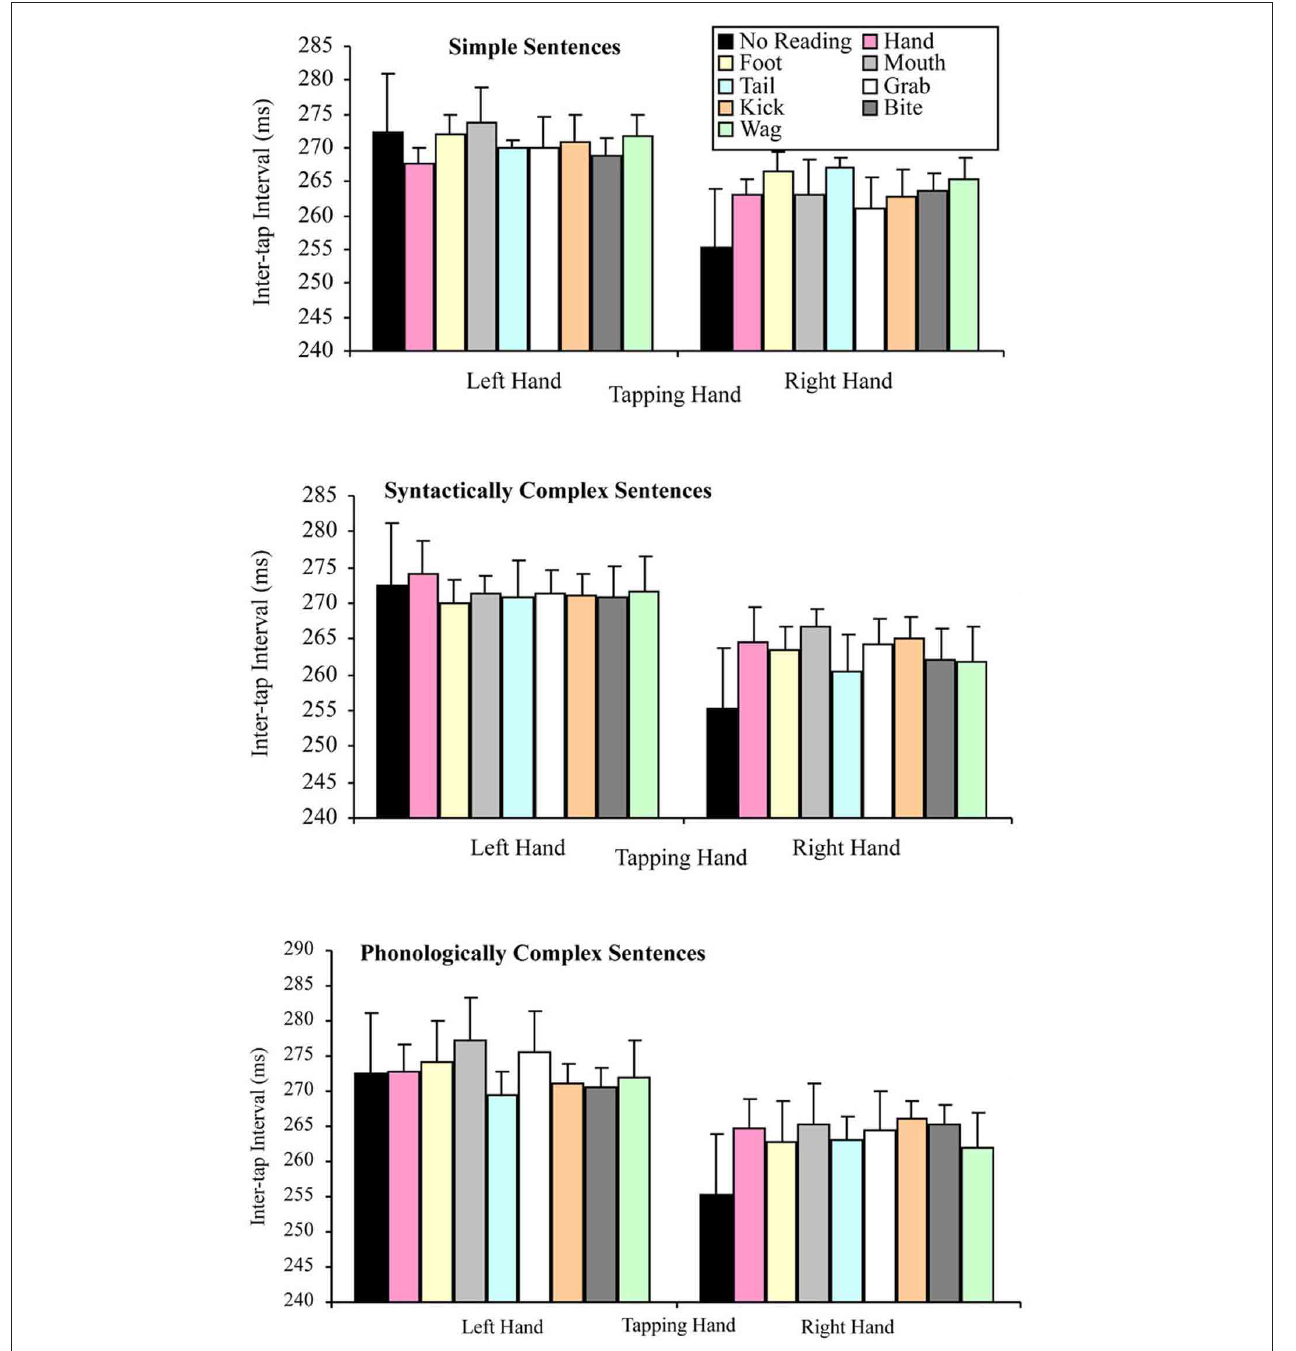
FIGURE 6 | Mean inter-tap intervals for the tapping hand × target word conditions for each type of sentence complexity in the reading silently data set (error bars represent the standard error of the mean).